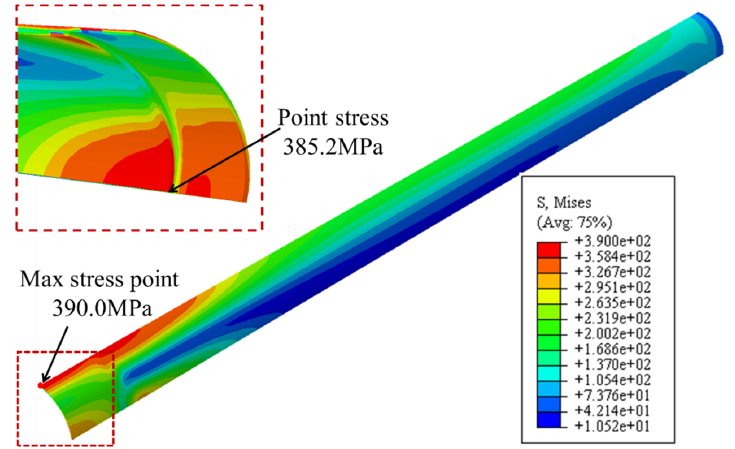
Figure 11. Stress distribution of the pipeline at the collapse pressure (unrepaired pipe).